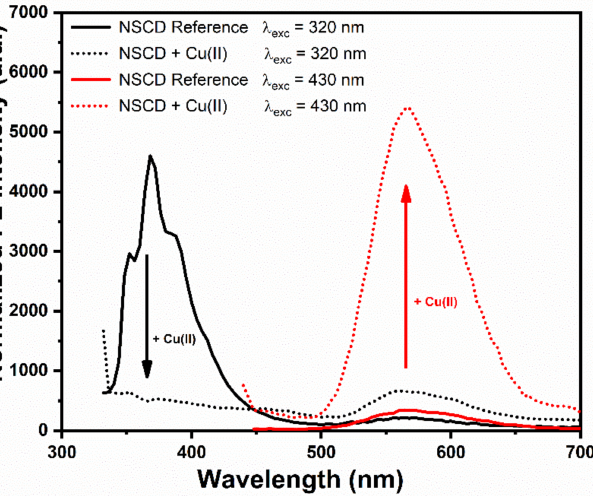
Figure 5. Variation of fluorescence emission of NSCD sensing solution excited at 320 nm (black curve) or 430 nm (red) upon the addition of 100 µ M